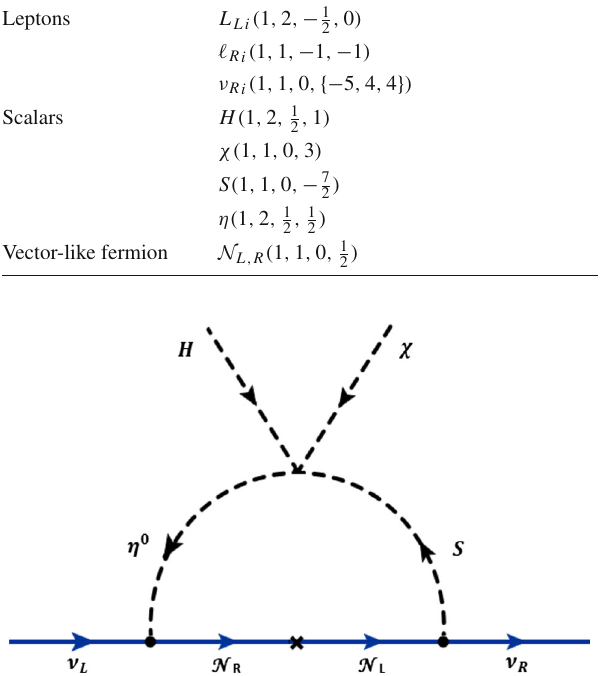
Fig. 3 RepresentativeFeynmandiagramforscotogenicDiracneutrino mass